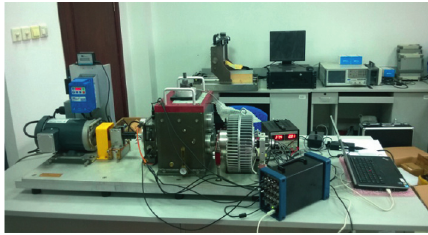
Figure 2: Fault diagnosis test bench for planetary gear